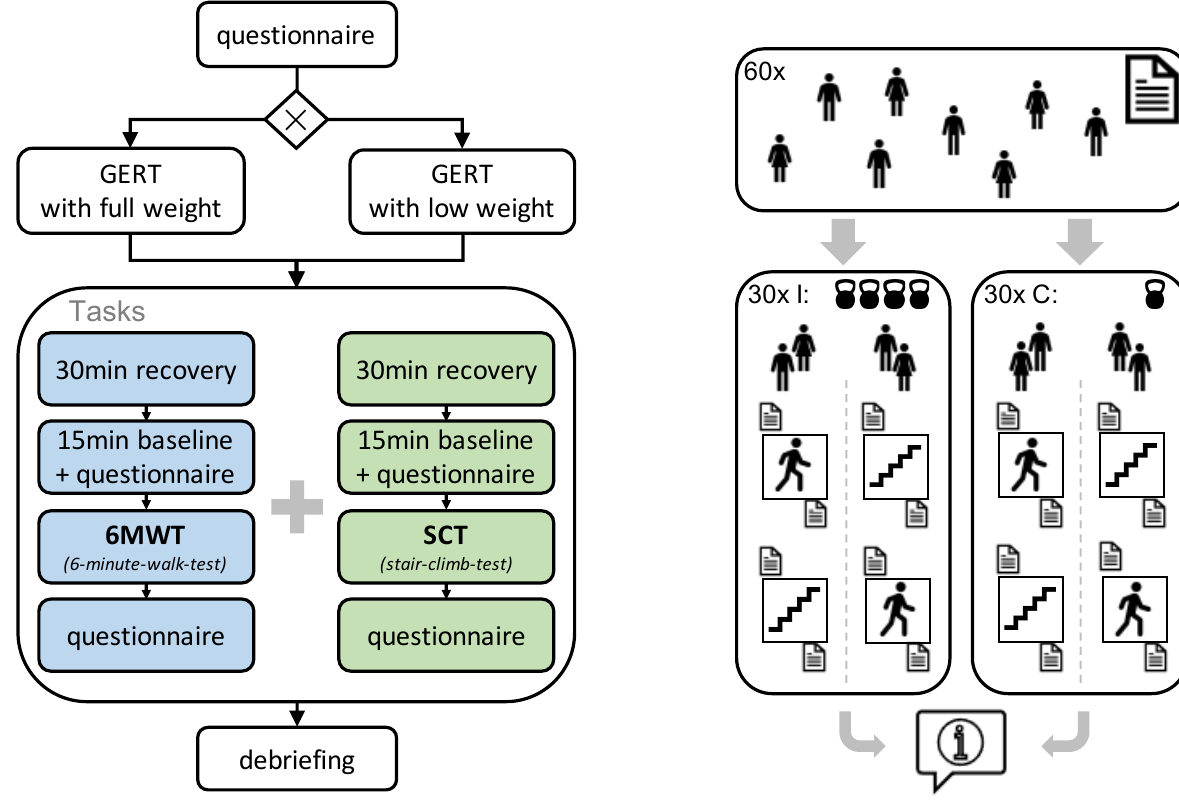
Figure 2. Sketches of the structure of the planned